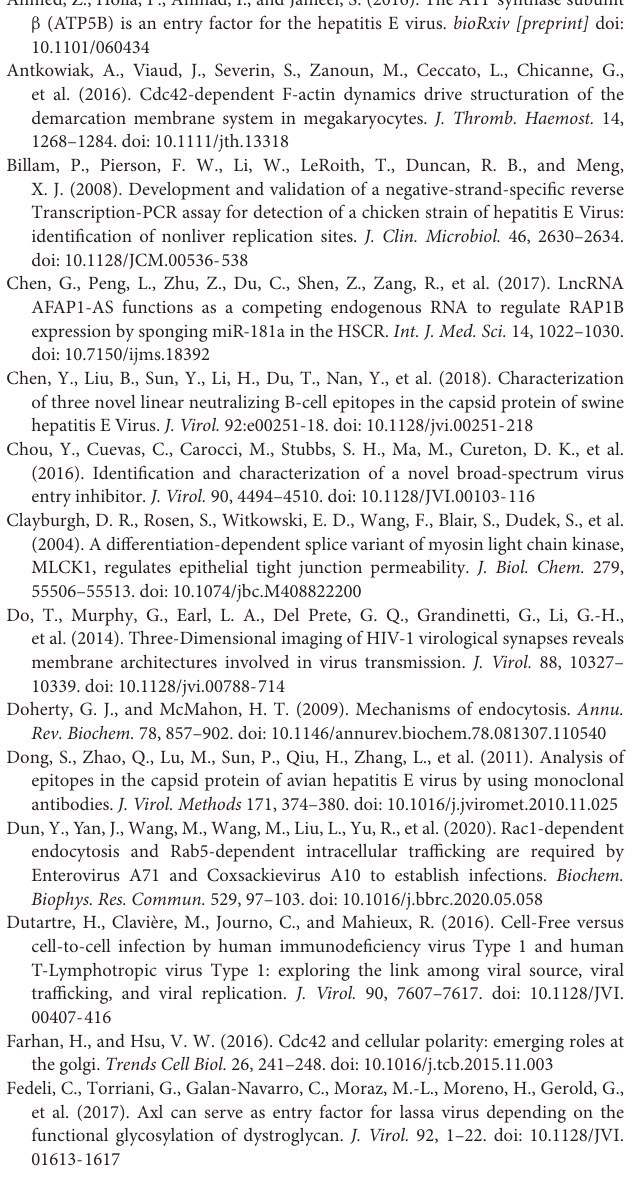
Supplementary Figure 3 | Positive correlations between expression levels of CDC42 and amount of CaHEV entering cells. Negative-strand RNA of CaHEV was detected by nested RT-PCR, and the size was approximately 250 bp. Blank control means the group of CaHEV-uninoculated LMH OATP1A2 cells; Extraction Control means the blank control on RNA extraction step; Round 1 and Round 2 control are the blank controls on Round 1 PCR and Round 2 PCR step, respectively. Supplementary Figure 4 | Cytotoxicity analysis of Rho family GTPases inhibitors in LMH OATP1A2 cells. (A) Cytocidal assay was performed using the CCK-8 kit on ML141-treated LMH OATP1A2 cells. (B) Cytotoxicity of Fasudil, NSC23766, IPA-3, Wiskostatin, ML7, and Blebbistatin in LMH OATP1A2 cells. Supplementary Figure 5 | Expression levels of the proteins of Rho GTPase family in siRNA-transfected LMH OATP1A2 cells. Protein levels of RhoA (A) , RAC1